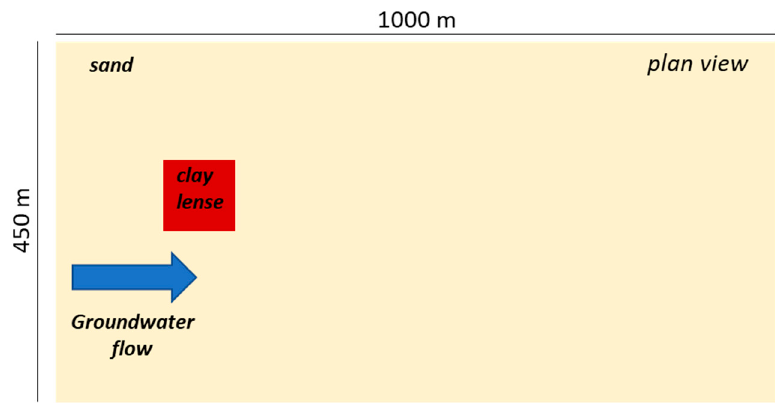
Figure 2. Model domain.